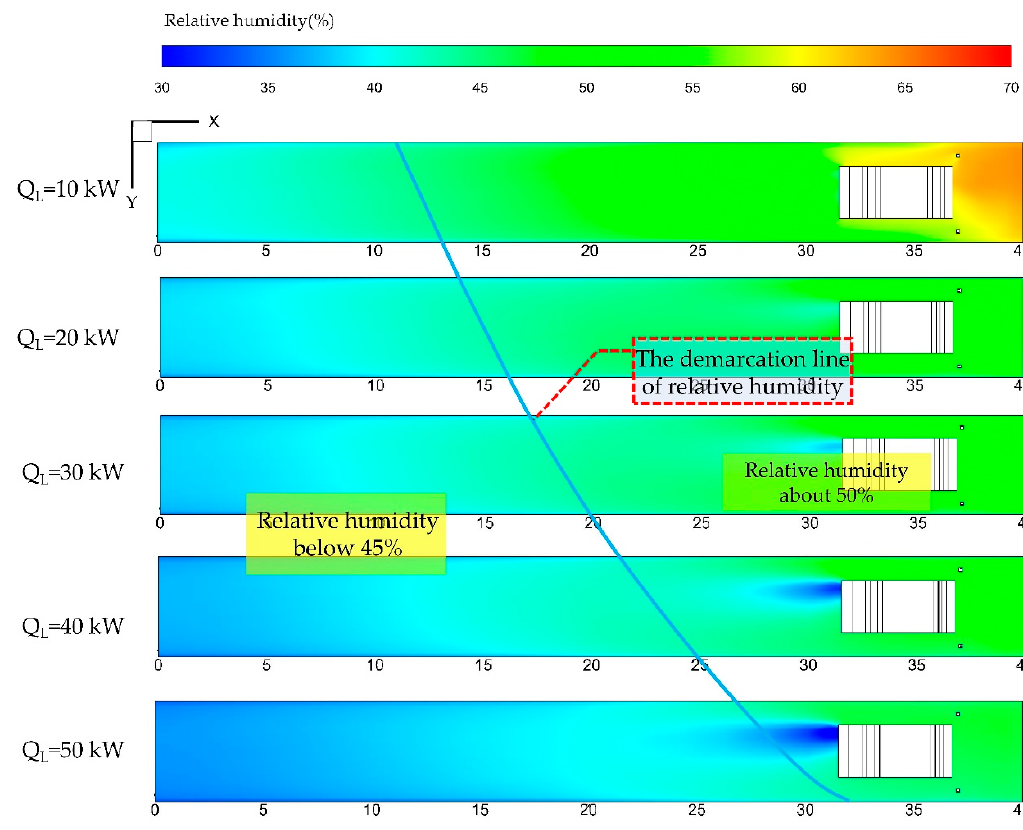
Figure 19. Airflow relative humidity distributions in Plane B with different Q L .